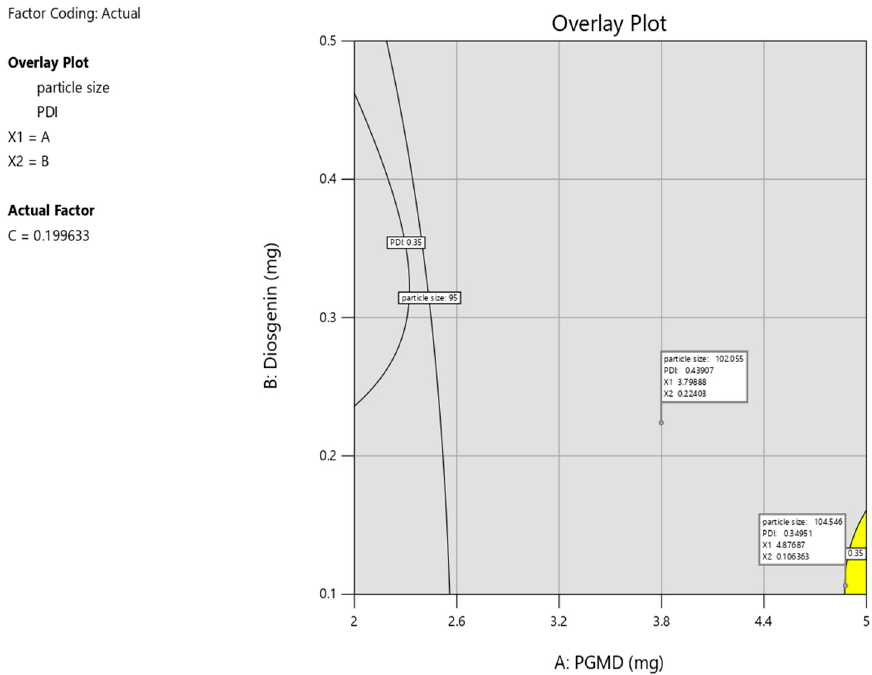
Figure 4. Overlay plot depicts a yellow region as an optimized area and flagged points as the compositions of optimized diosgenin loaded PGMD